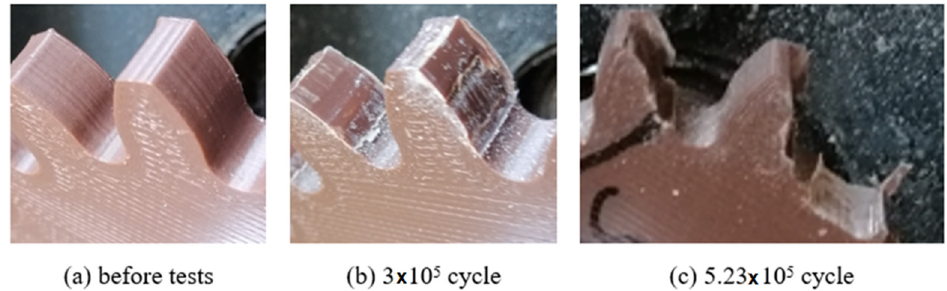
Figure 7. Service life of gears fabricated of ABS.